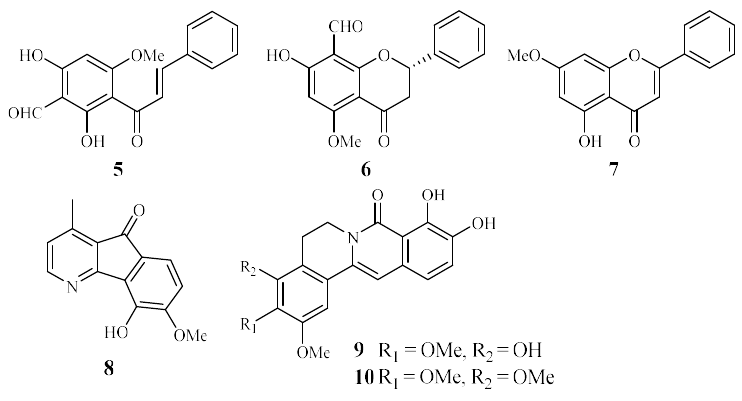
Figure 3. Compounds from Annonaceae plants.